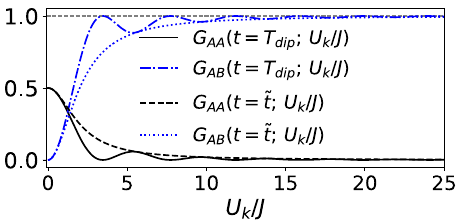
Fig. 5 Correlations dependence from polariton nonlinearity. The curves labeled as G AA ( t = T dip , U k / J ) and G AB ( t = T dip , U k / J ) describe the behavior of auto- and cross-correlation functions, respectively, for t = T dip and as a function of the polariton two-body interaction, U k / J . The condition U k / J = 0 corresponds to the Hong-Ou-Mandel effect, i.e., G AA ( t = T dip , U k / J = 0) = 0.5 and G AB ( t = T dip , U k / J = 0) = 0, respectively. Dotted and dashed curves describe the dependence of the G AA maximum and G AB minimum values, respectively, on U k / J . Such a condition is identi fi ed by Fig. 6 Analog Ramsey interferometer in QPIC. a Sketch of a polariton